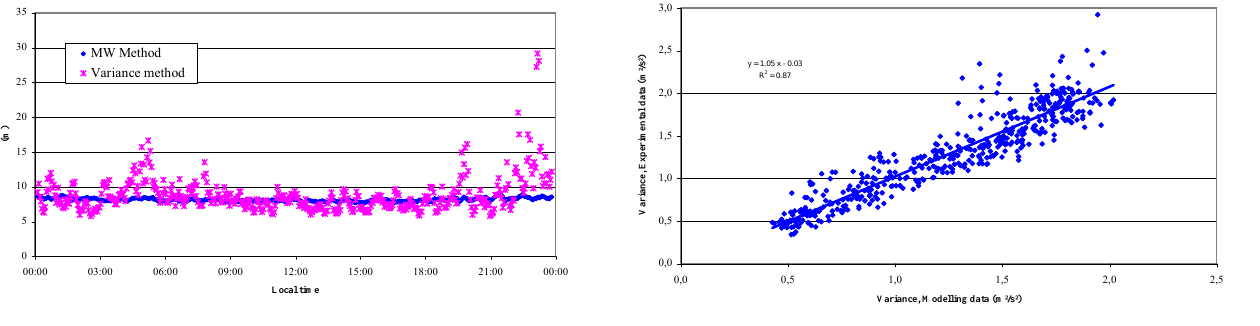
Figure 8.a: Roughness length. Comparison between the statistical method MW and the Fig. 8a. Roughness length. Comparison between the statistical variance method (Plot CT, 25 July 1997) method MW and the variance method (Plot CT, 25 July 1997).